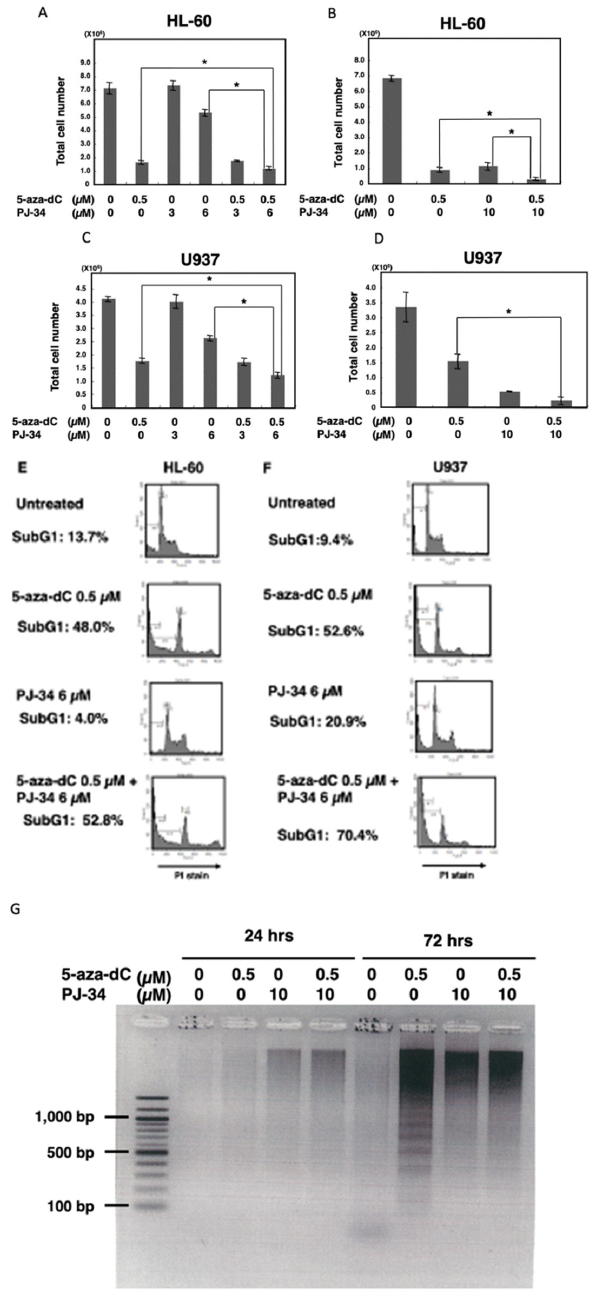
Figure 1. The effect of PJ-34 on the cytotoxicity of 5-aza-dC in HL-60, U937 cells. ( A , B ) HL-60 cells were treated with 5-aza-dC and PJ-34 or a combination of these chemicals for 6 days in separate experiments. ( C , D ) U937 cells were treated with 5-aza-dC and PJ-34 or combination of these chemicals for 6 days in separate experiments. The viable cell number was counted. * p < 0.05, Mean ± S.E. ( E , F ): HL-60 and U937 cells were treated with 5-aza-dC and PJ-34 or a combination of these chemicals and analyzed with flow cytometry by staining of DNA with propidium iodide (PI) at 72 h. SubG1 %, which corresponds to cells with less intensity of PI staining compared to that of G1 phase, is indicated. ( G ) HL-60 cells were treated with 5-aza-dC and PJ-34 or a combination of these chemicals and DNA fragmentation was analyzed at 24 and 72 h.